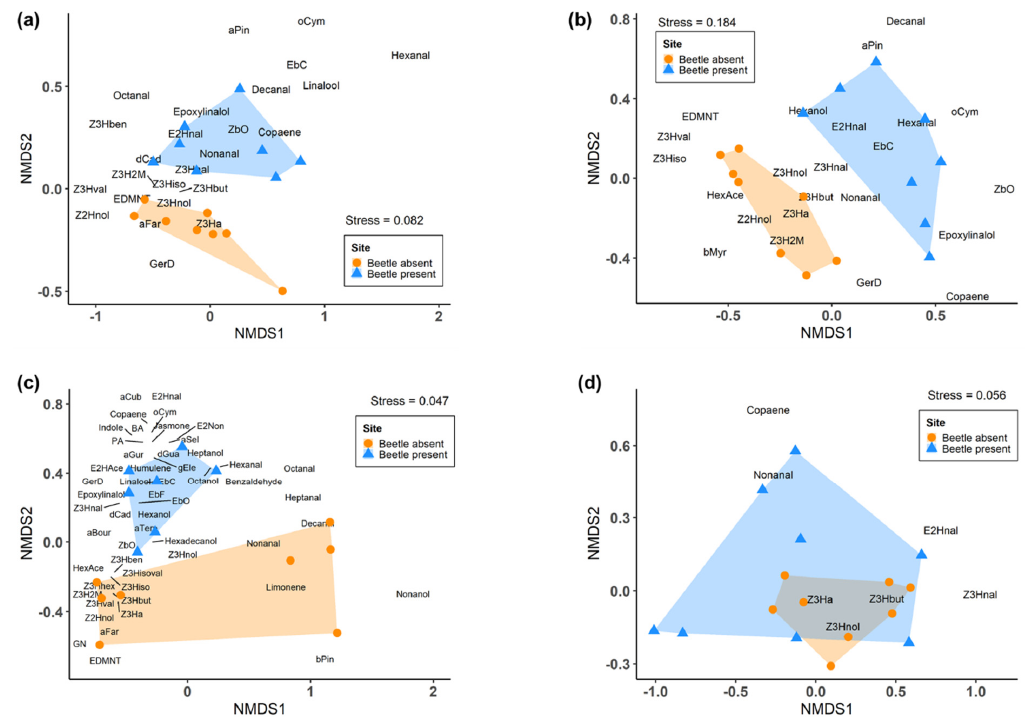
Figure 5. Non-metric multidimensional scaling (NMDS) plots showing the first (NMDS1) and second (NMDS2) axes of VOCs identified from heather at beetle-present and beetle-absent sites in ( a ) November 2018, ( b ) December 2018, ( c ) January 2019 and ( d ) March 2019. N = 7 for the beetle-present site in (c), otherwise 8 replicates per treatment were done in all sampling times. Abbreviations: ( Z )-3-hexenyl benzoate (Z3Hben), δ -cadinene (dCad), ( E )-2-hexanal (E2Hnal), ( Z )-3-